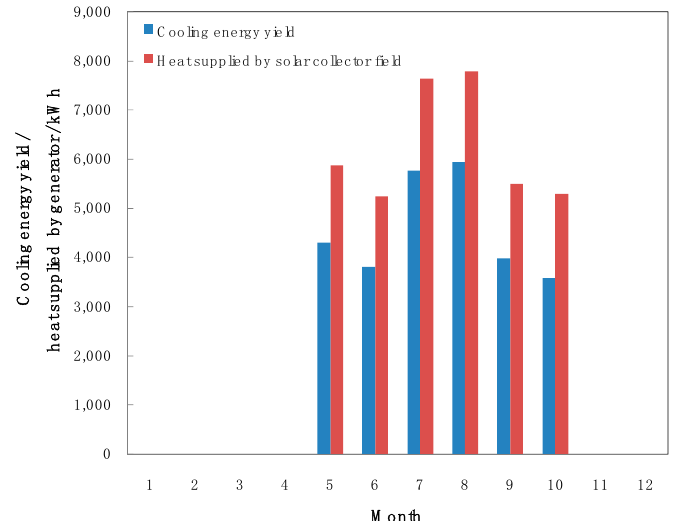
Figure 12. The monthly cooling energy yield of the absorption chiller and heat supplied by the solar collector field in 2018.